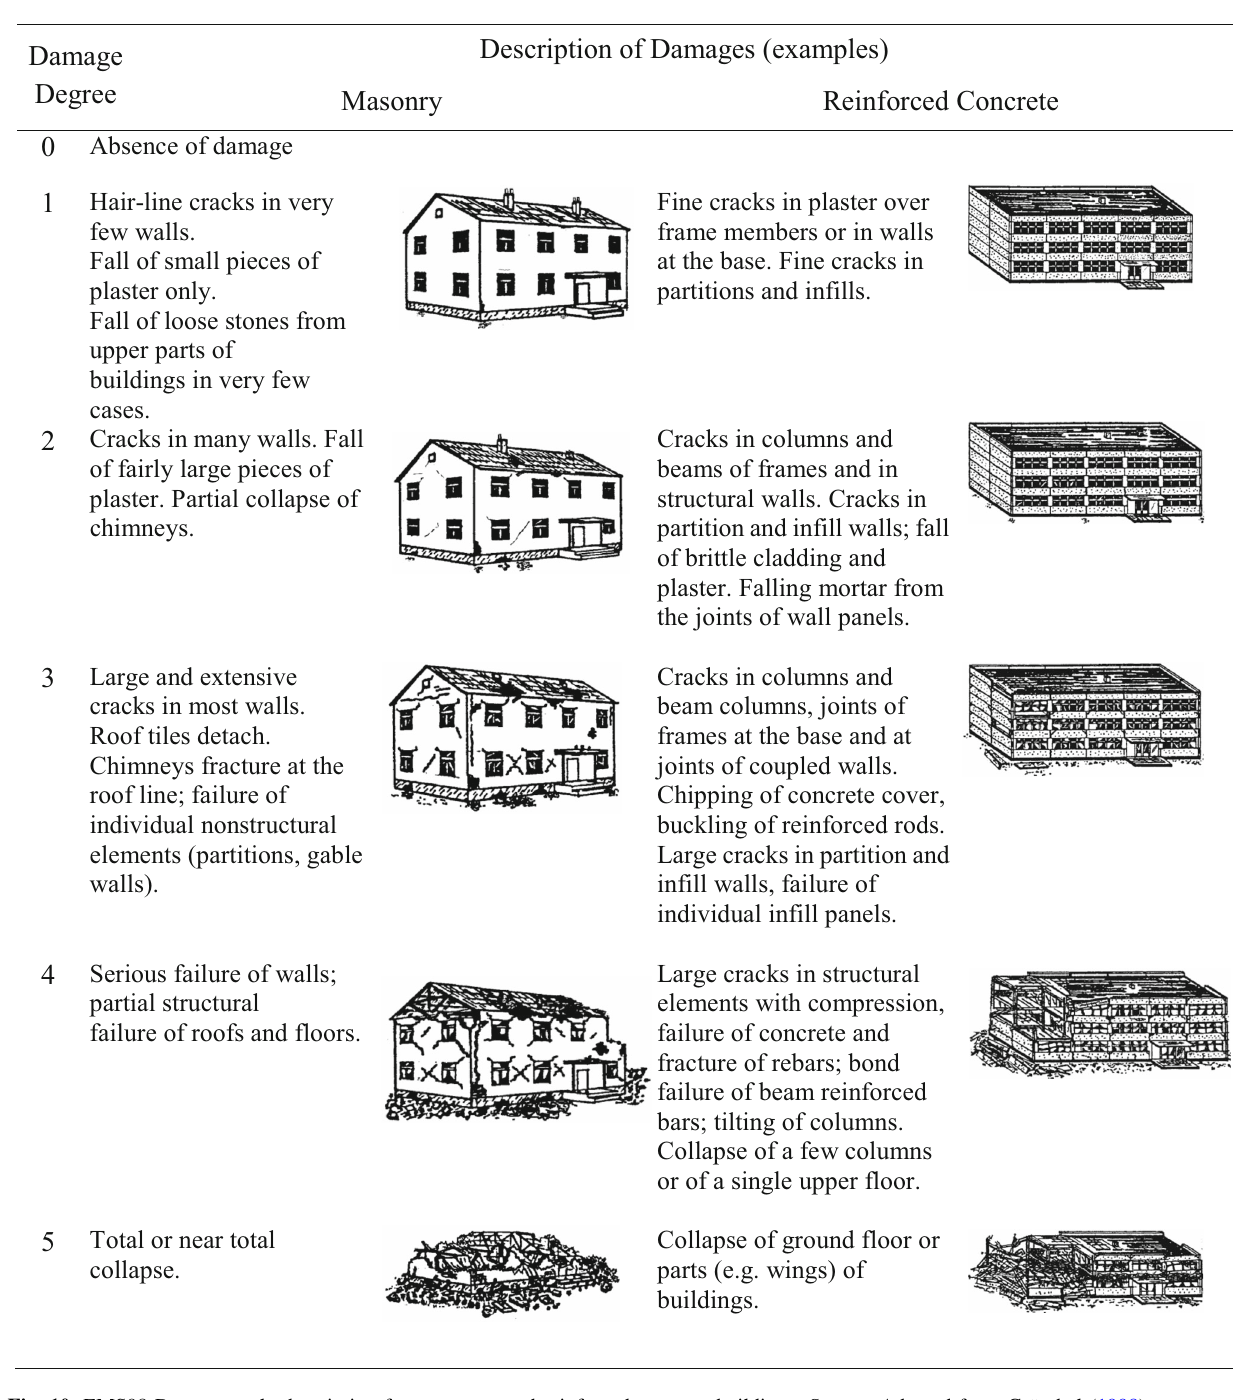
Fig. 10 EMS98 Damage scale description for masonary and reinforced concrete buildings. Source : Adapted from Gru¨nthal